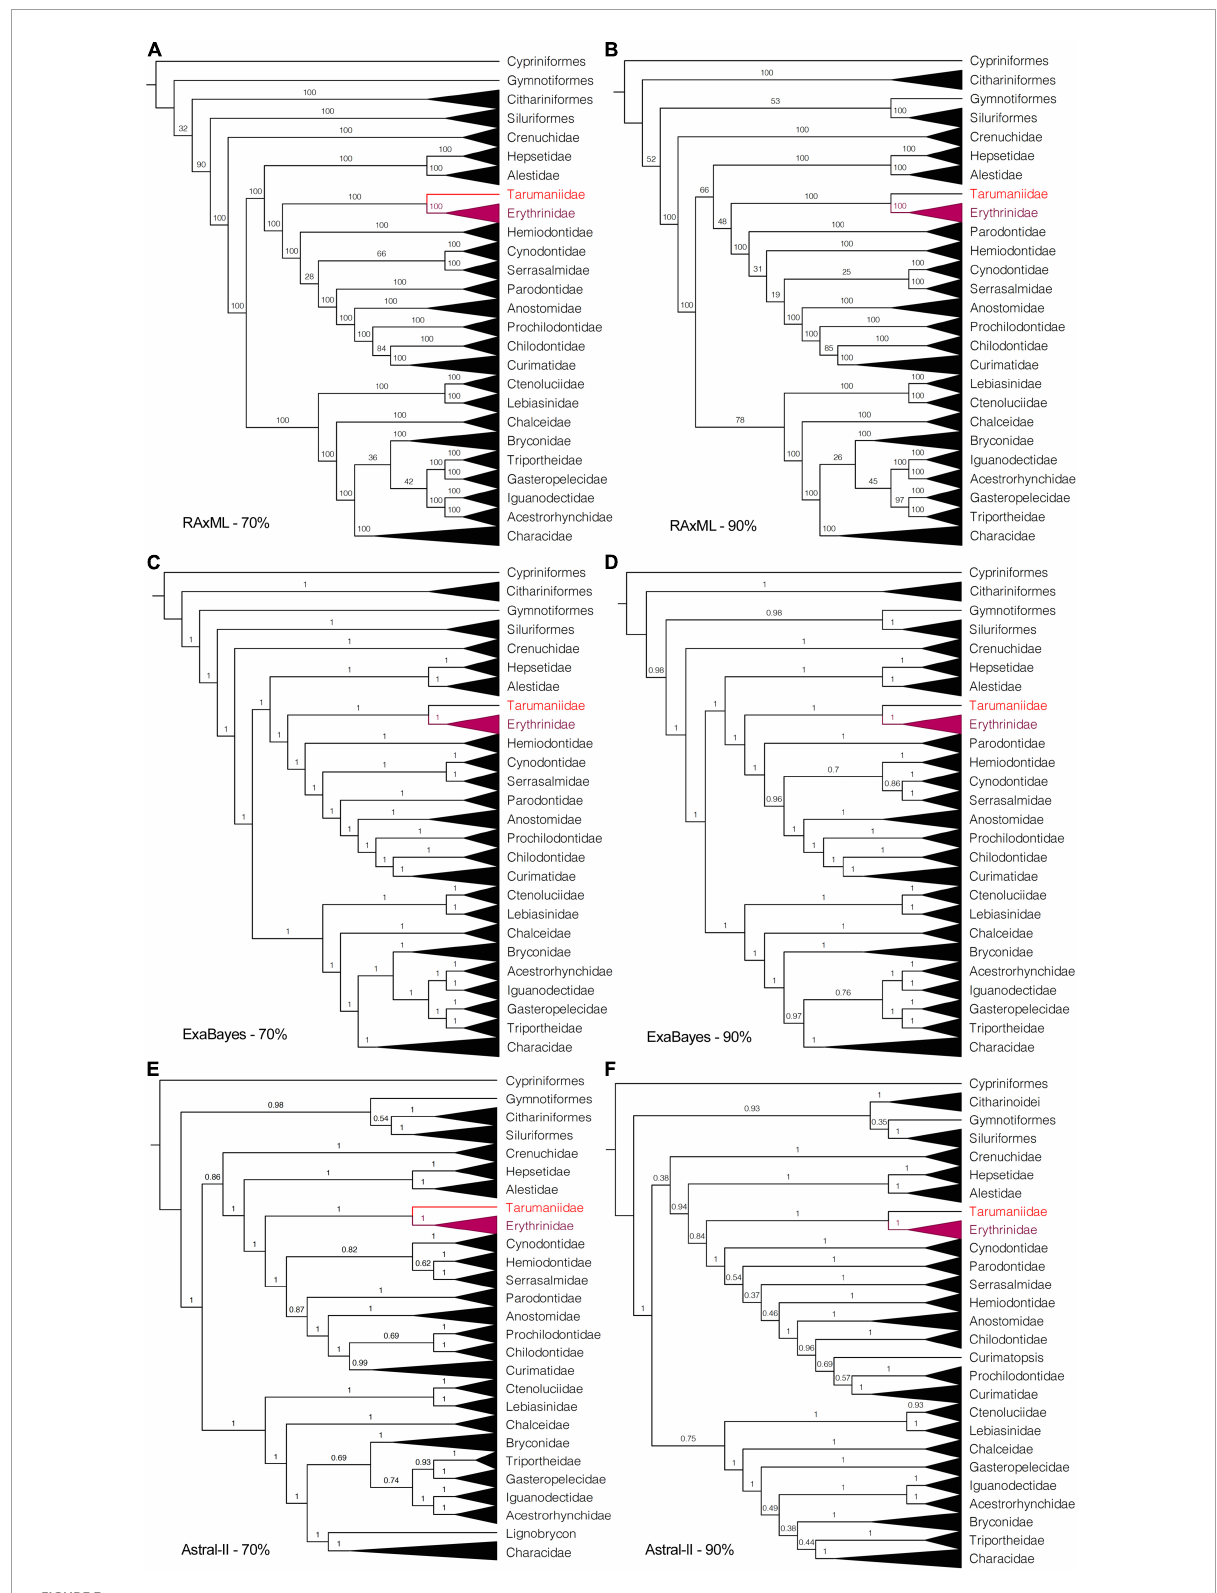
FIGURE3 Phylogenetic placements of Tarumaniidae (red) and Erythrinidae (maroon) in Characiformes using the first (1795 loci; 70% complete) and second (172 loci; 90% complete) matrices of ultraconserved elements (UCEs): Maximum likelihood in RAxML (A,B) , Bayesian approach in ExaBayes (C,D) , Coalescent-based analysis in ASTRAL-II (E,F) .